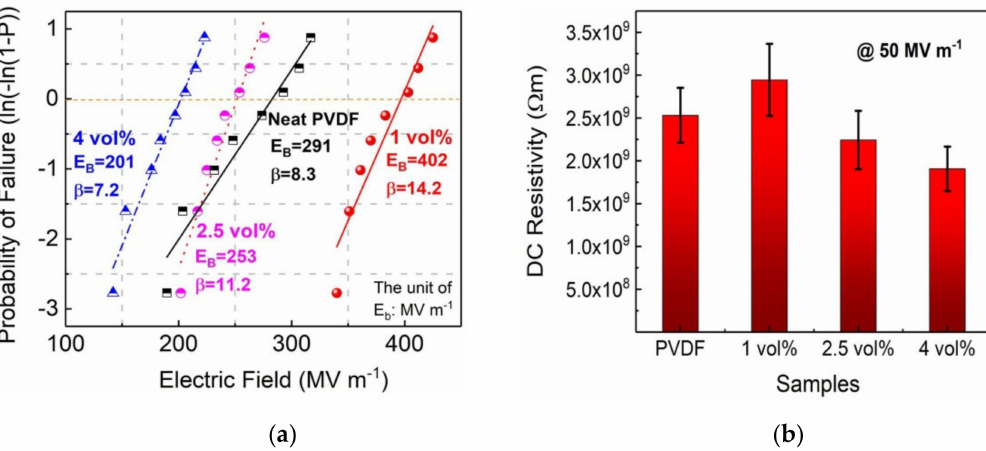
Figure 4. ( a ) Weibull breakdown field distribution, ( b ) DC electrical resistivity at 50 MV m − 1 of PVDF and composites with SrTiO 3 @SiO 2 platelets.